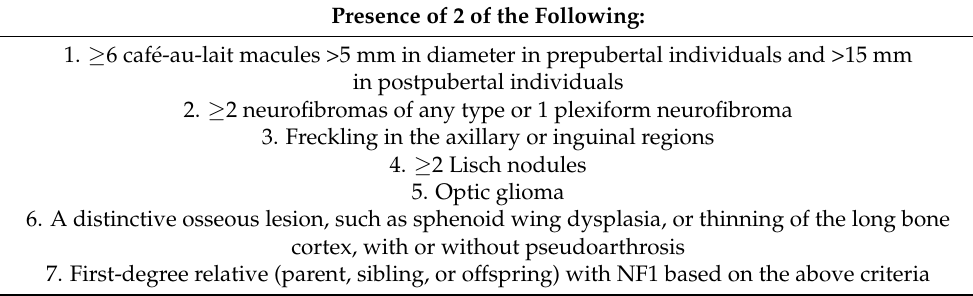
Table 1. National Institutes of Health clinical diagnostic criteria for neurofibromatosis type 1 [6]. Presence of 2 of the